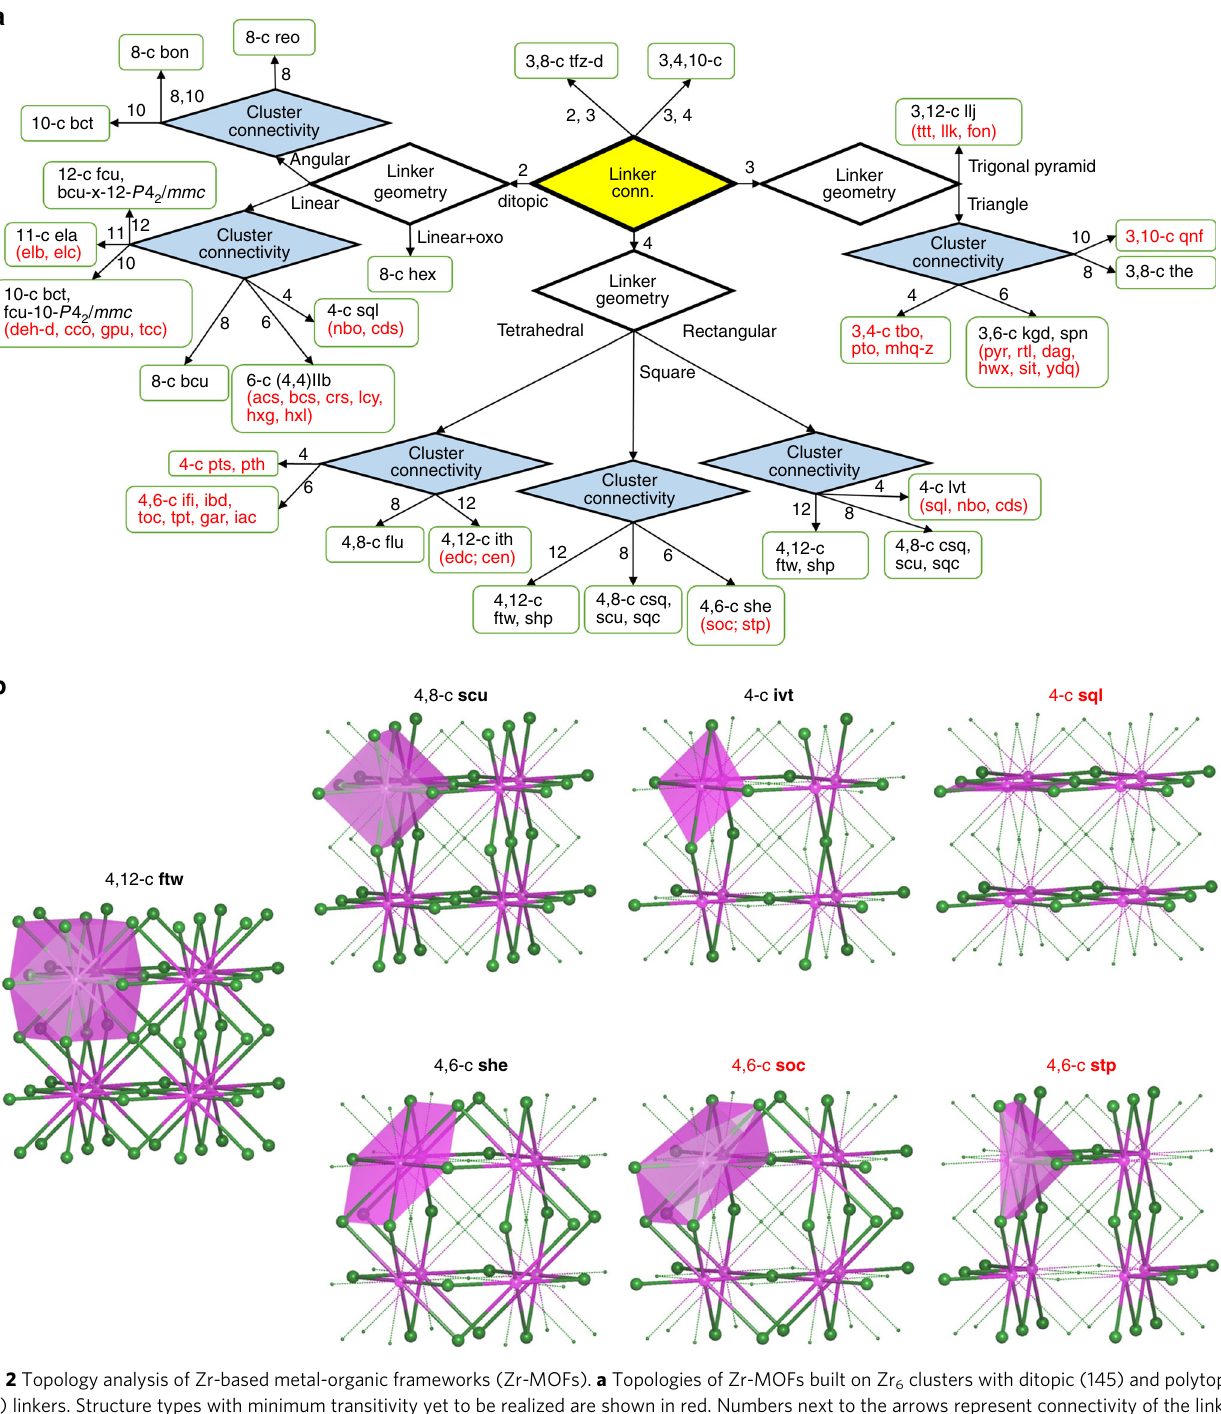
Fig. 2 Topology analysis of Zr-based metal-organic frameworks (Zr-MOFs). a Topologies of Zr-MOFs built on Zr 6 clusters with ditopic (145) and polytopic (56) linkers. Structure types with minimum transitivity yet to be realized are shown in red. Numbers next to the arrows represent connectivity of the linker or cluster. b ftw net and its subnets with minimum transitivity (magenta and green balls represent the nodes of Zr 6 clusters and linkers, respectively). Structure types yet to be realized are shown in